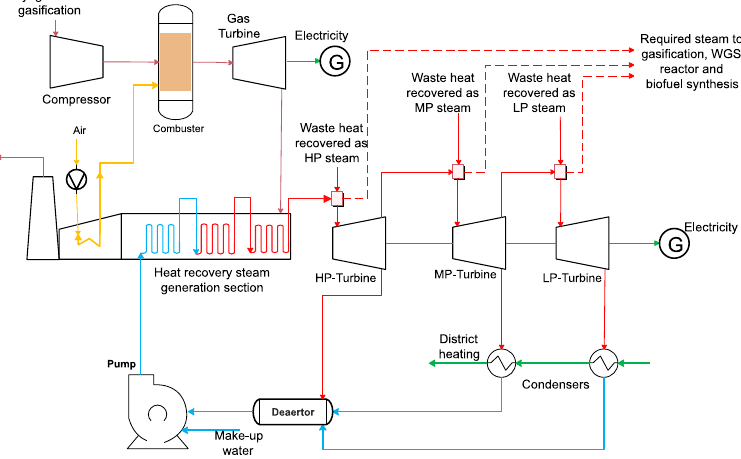
Figure 9. Process flow diagram of power and heat produced from combustion of syngas produced from waste gasification.